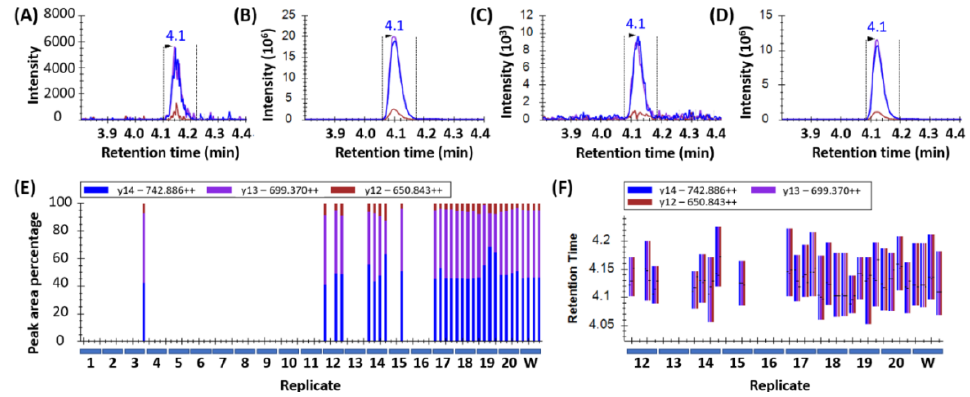
Figure 1. Wheat peptide (DVSPGCRPITVSPGTR from HMW-GS, Uniprot: Q45R38) peak detection in yeast samples: ( A ) Sample 17 (intensity 6.0 × 10 3 ); ( B ) sample 18 (intensity 2.0 × 10 7 ); ( C ) sample 20 (intensity 1.0 × 10 4 ); and ( D ) wheat (control, intensity 1.2 × 10 7 ). The peaks were detected using